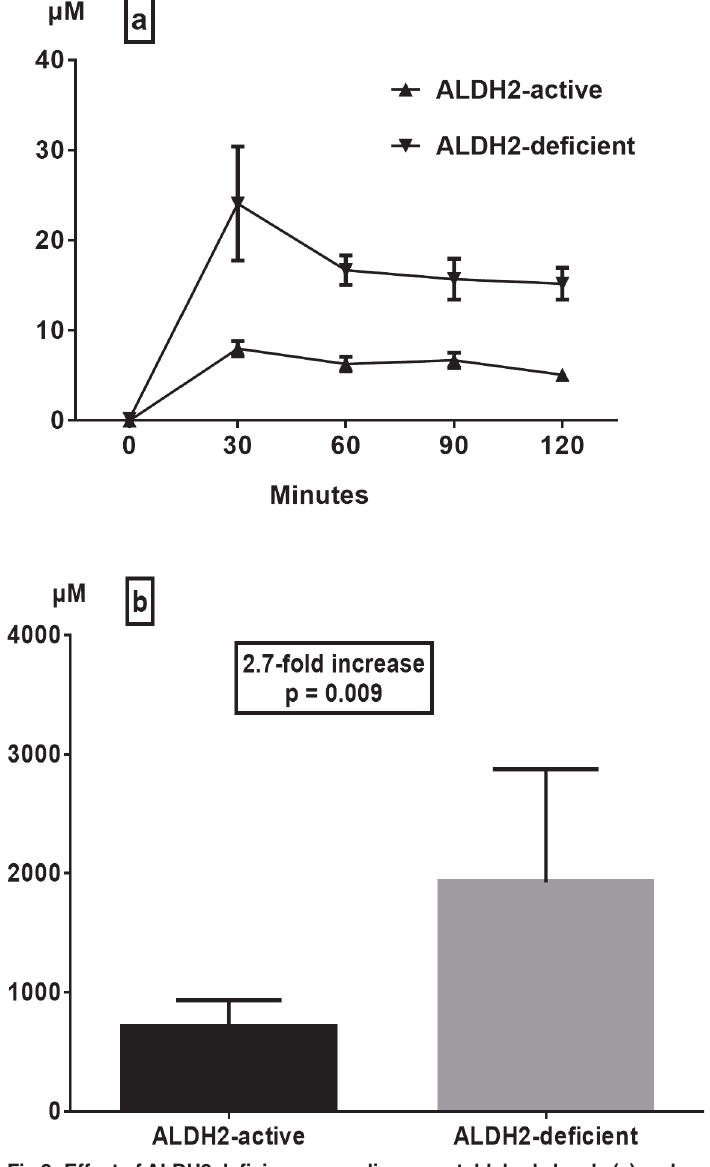
Fig 2. Effect of ALDH2 deficiency on salivary acetaldehyde levels (a) and areas under the curve (b) after intragastric infusion of ethanol (15 vol%, 0.5 g/kg) (means ± SEM).